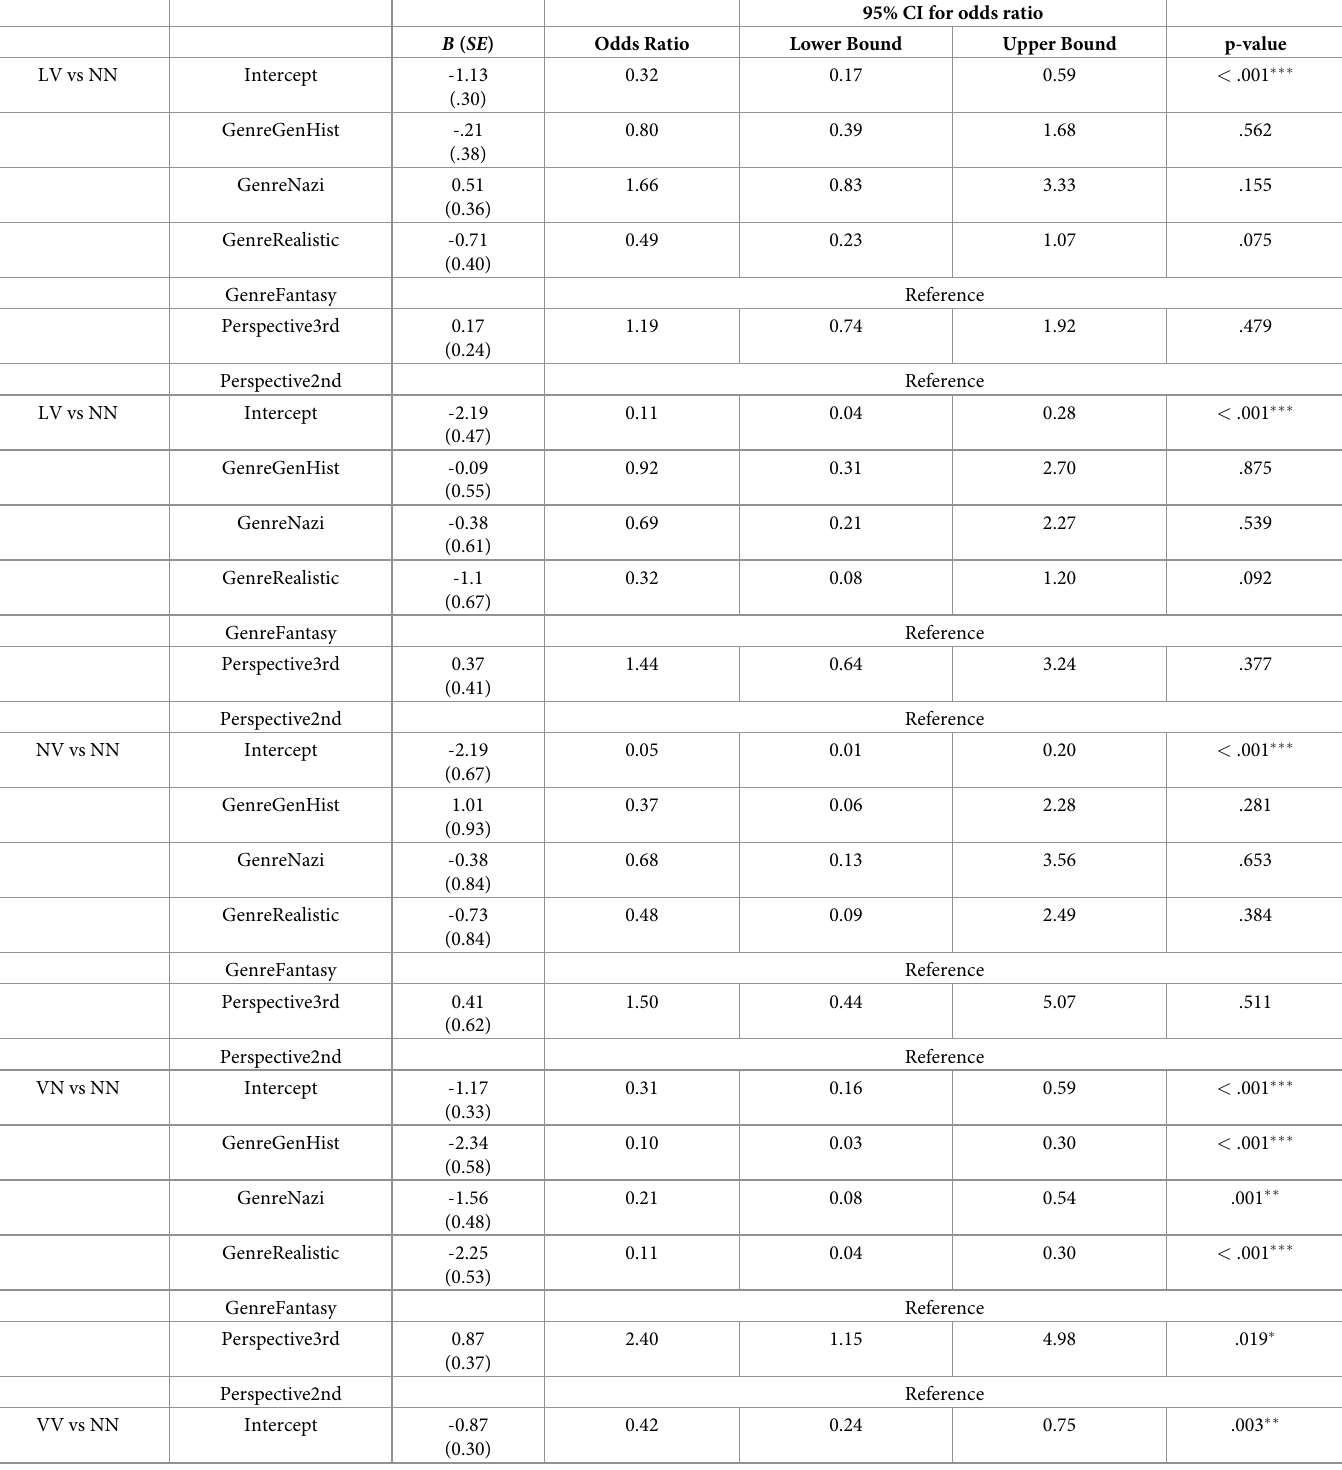
Table 4. Results of multinomial logistic regression: effect of genre and perspective on story path (six